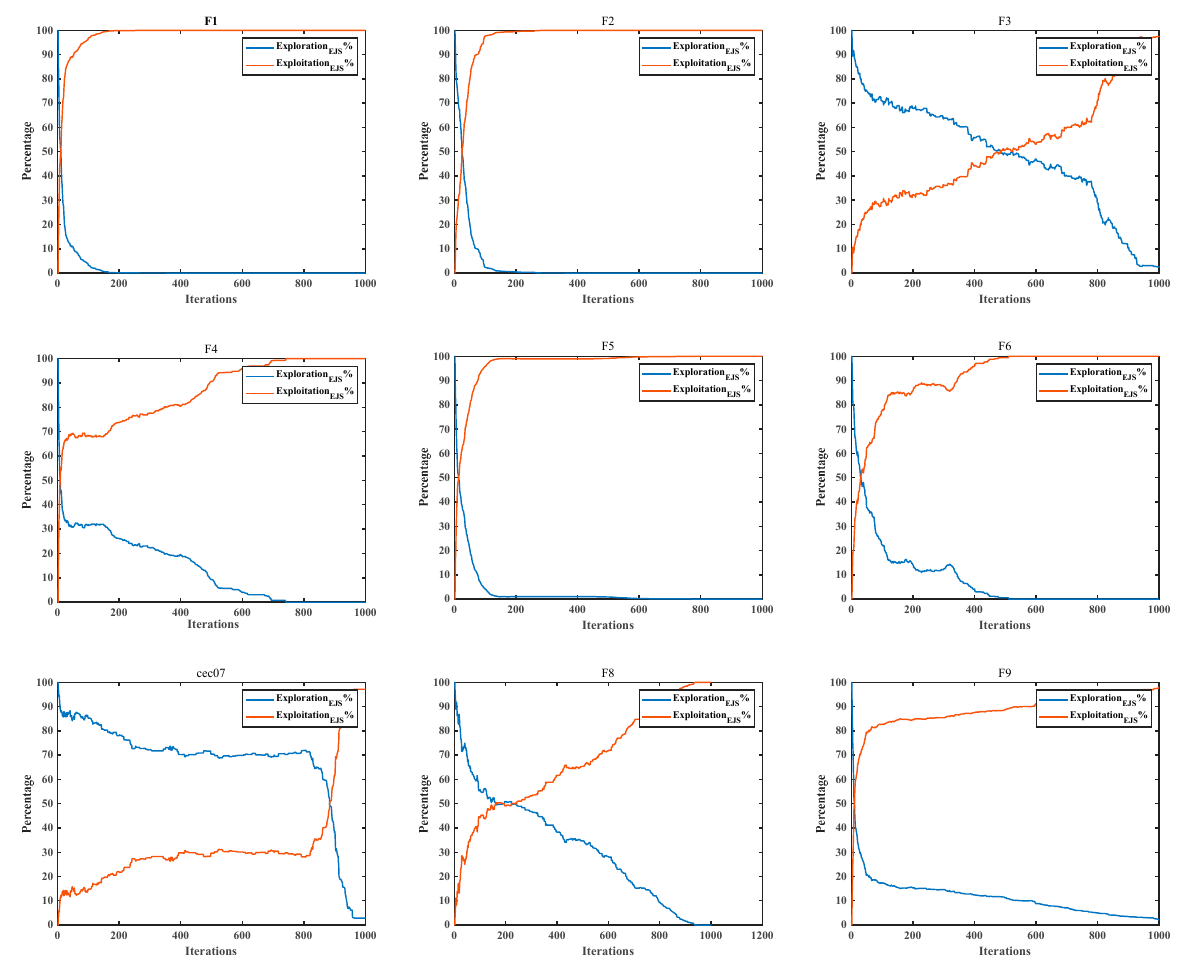
Figure 7. The exploration and exploitation diagrams of the EJS algorithm.